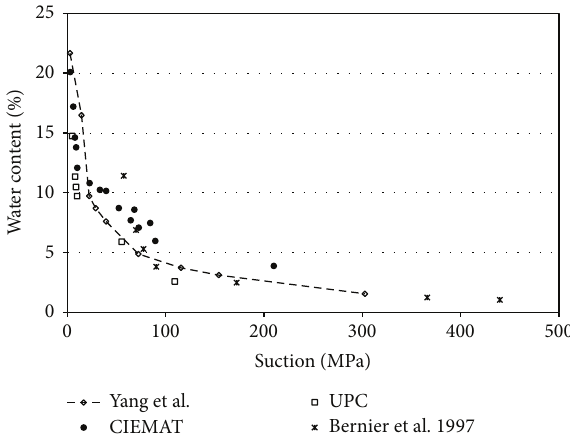
Figure 3: The comparison of the water retention curves of different studies.